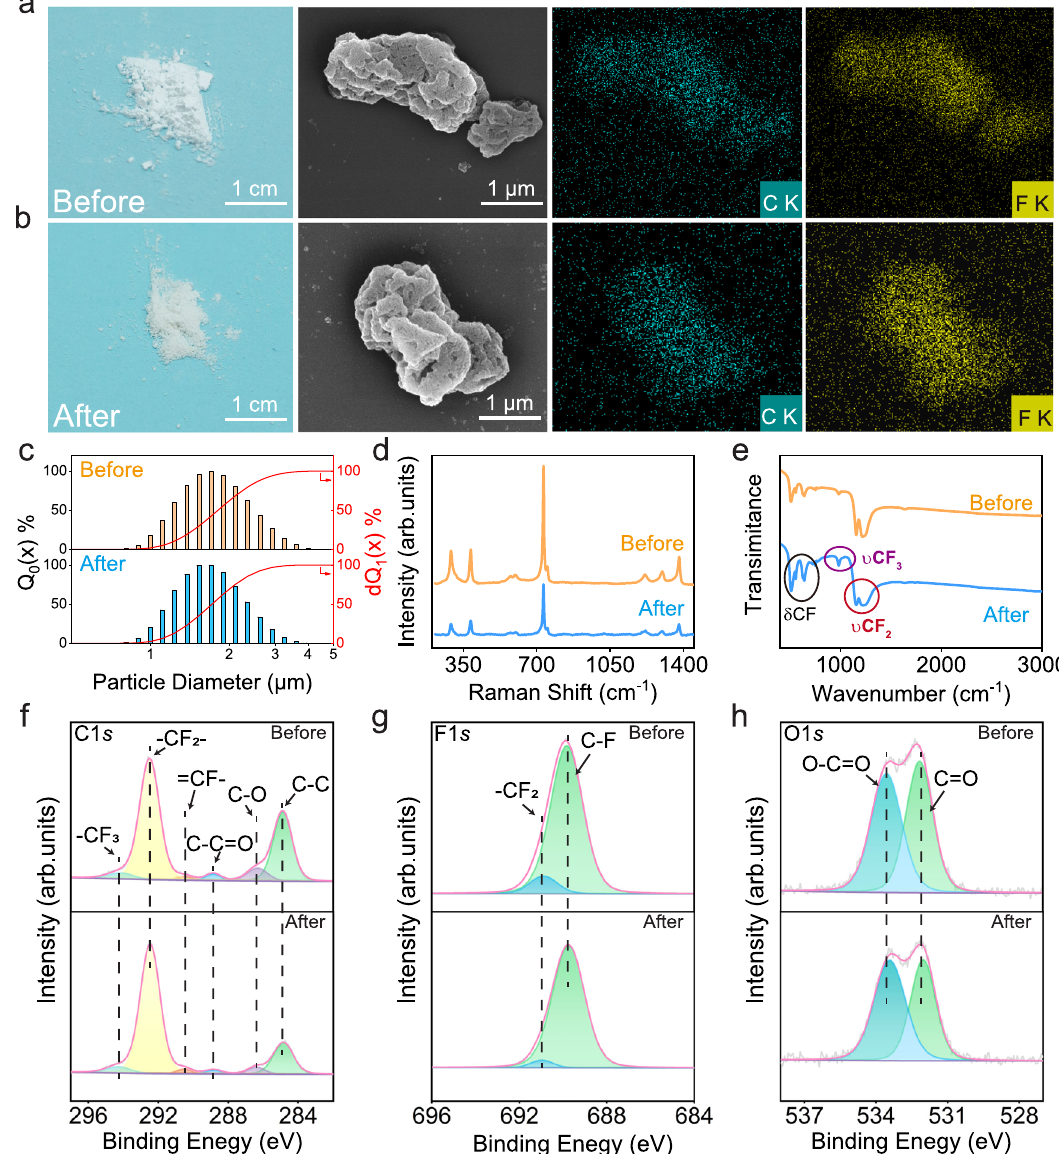
Fig. 2 Characterization of FEP powder before and after contact-electro-catalysis. a Morphological characterization and energy dispersive X-ray (EDX) analysis of the FEP powder before reaction, as well as b , after the reaction. c Particle size distribution of FEP powder. d Raman spectra before (orange) and after (blue) the reaction. e Fourier Transform Infrared (FTIR) spectra before (orange) and after (blue) the reaction. f C1 s g F1 s, and h O1 s XPS spectra of FEP powder before and after the